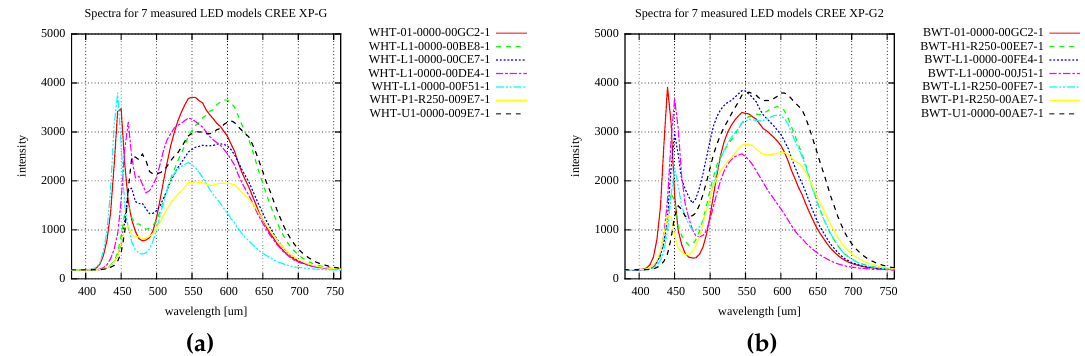
Figure 8. The spectral characteristics of evaluated light emitting diode (LEDs), (a) CREE X-lamp XP-G and (b) its newer version XP-G2, all performance groups into which producer classifies the LED one by one.